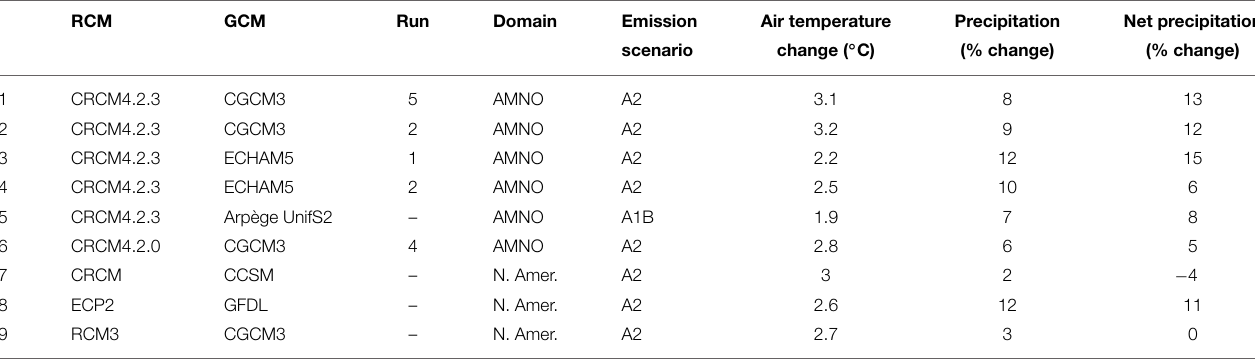
TABLE 1 | Details for the nine climate projections selected for this study out of the group of 25 available for the region: emission scenario, simulated air temperature and precipitation changes, and derived potential evapotranspiration changes (derived from Levison et al., 2014b). RCM GCM Run Domain Emission Air temperature Precipitation Net precipitation scenario change ( ◦